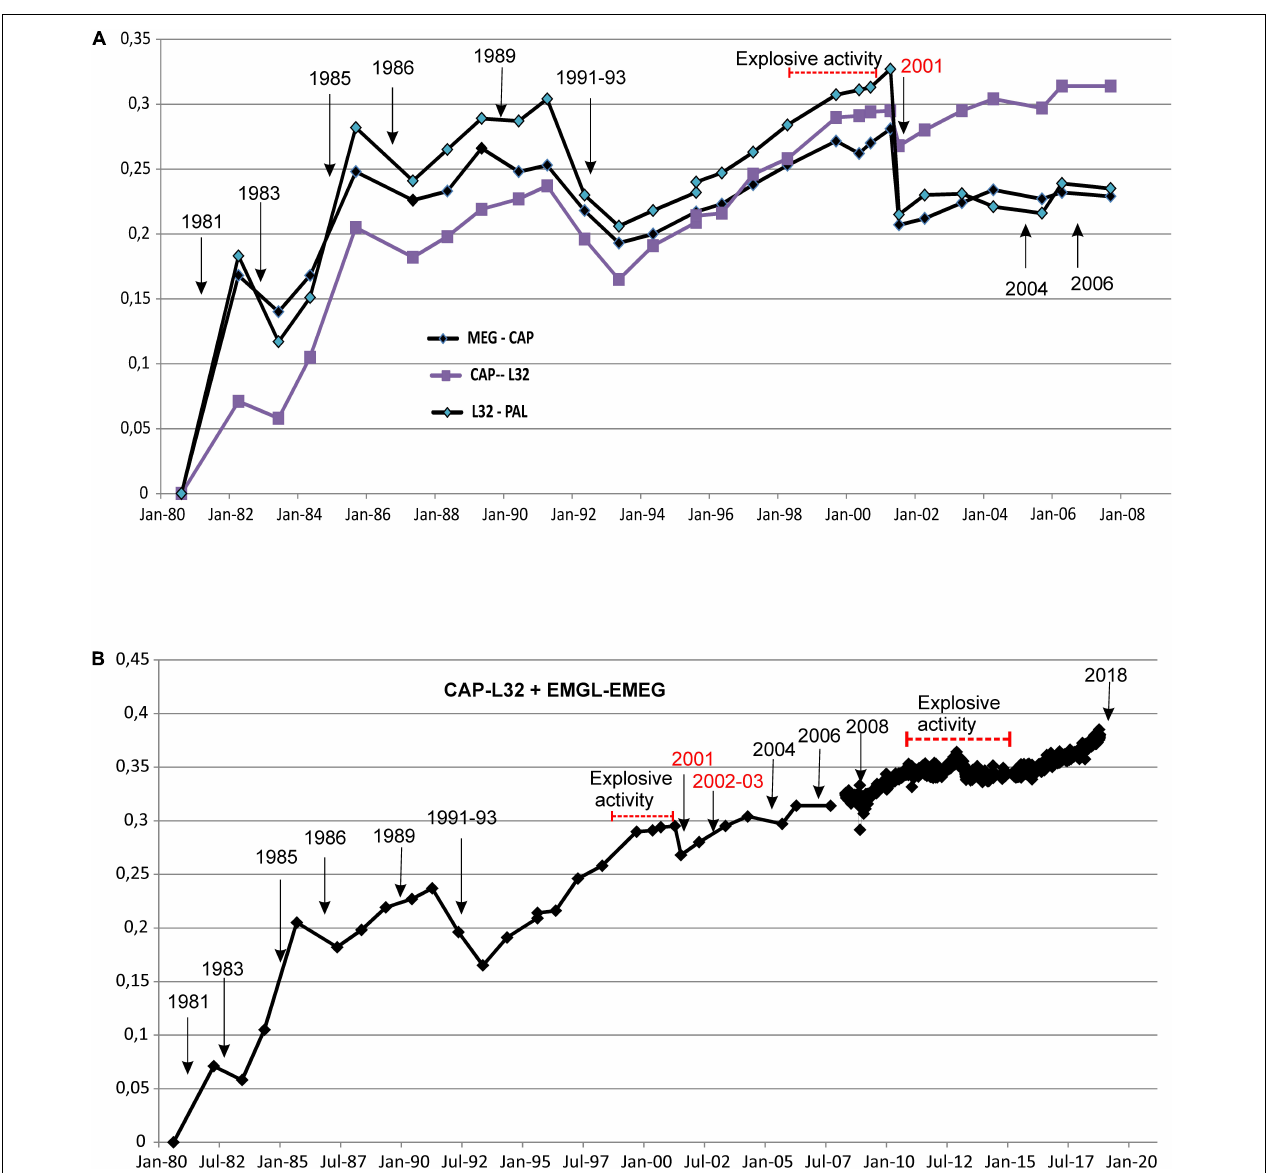
FIGURE 3 | Baseline changes (m) over 40 years of measurements in the W flank of Etna volcano. (A) Selected EDM baselines striking in a near N-S direction in the time interval 1980–2007. (B) EDM baseline CAP-L32 from 1980 to 2007 continuing from 2007 to 2018 with the CGPS baseline EMEG-EMGL that is also in the western flank with similar direction. The arrows marking the main flank eruption are